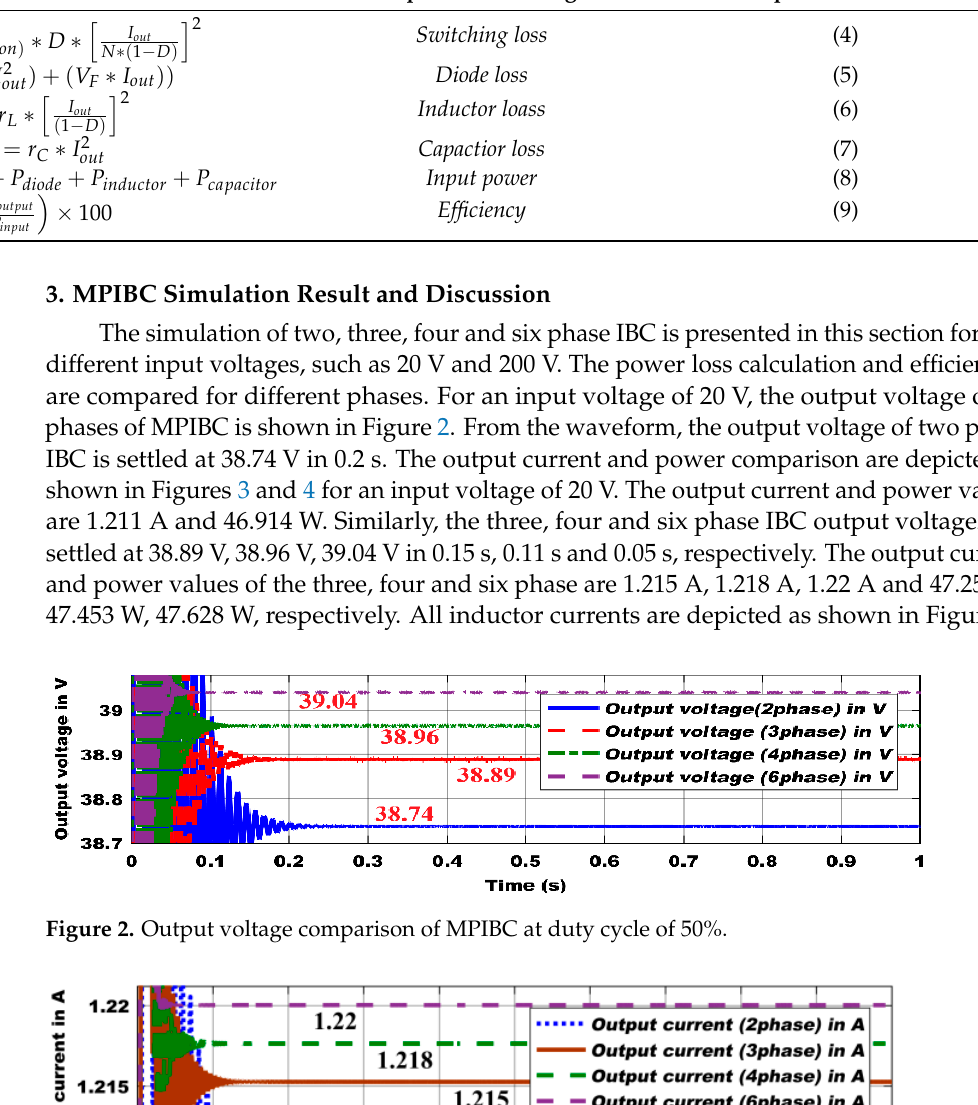
Table 4. Loss estimation equation for MPIBC.